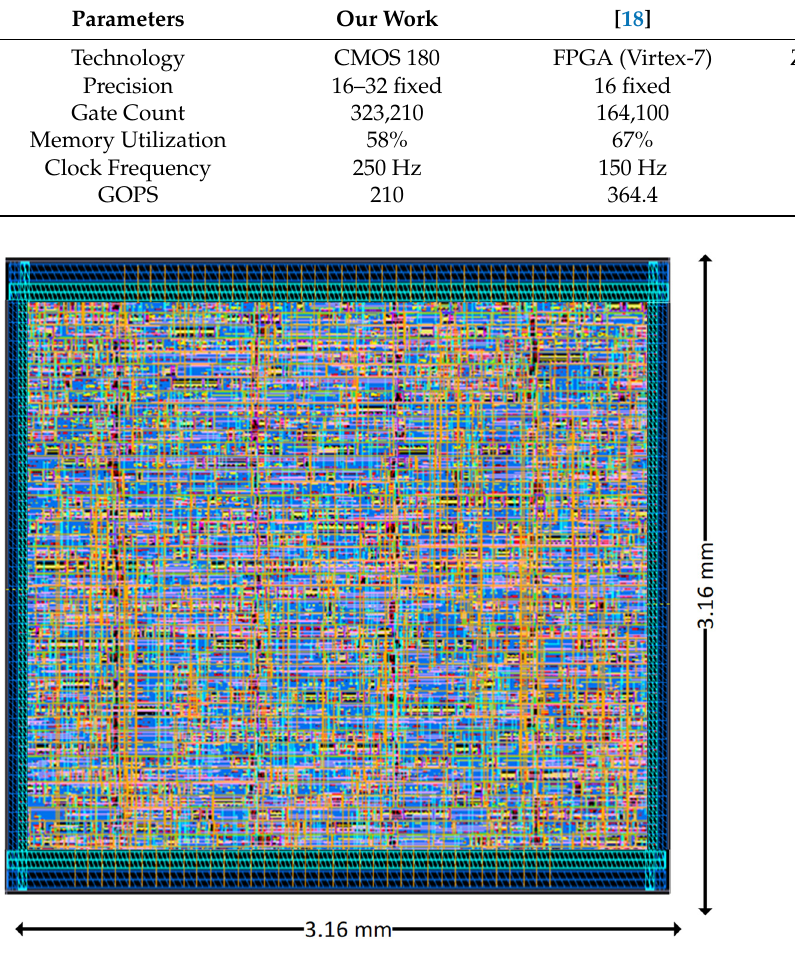
Figure 11. Layout of the proposed CNN engine. Table 1. Tested Dataset.